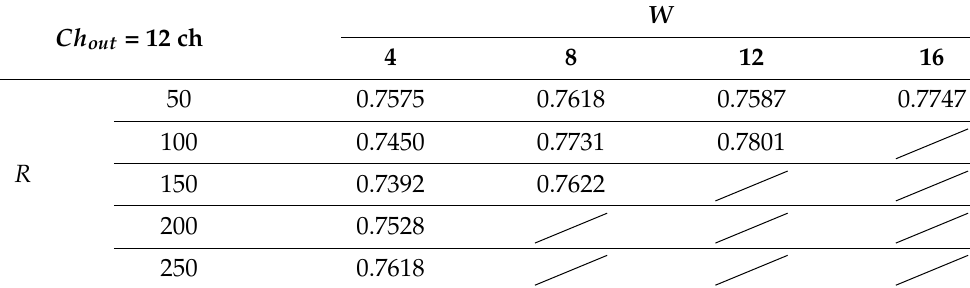
Table 11. Accuracy of parameter search at Ch out = 12 ch.